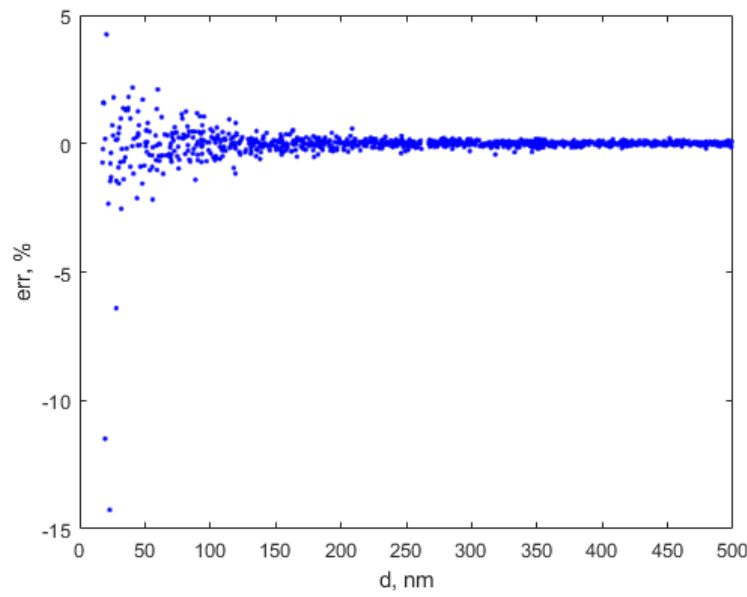
Figure 3. The variation of the relative errors for the diameter range [20 – 500] nm, computed with ANN.